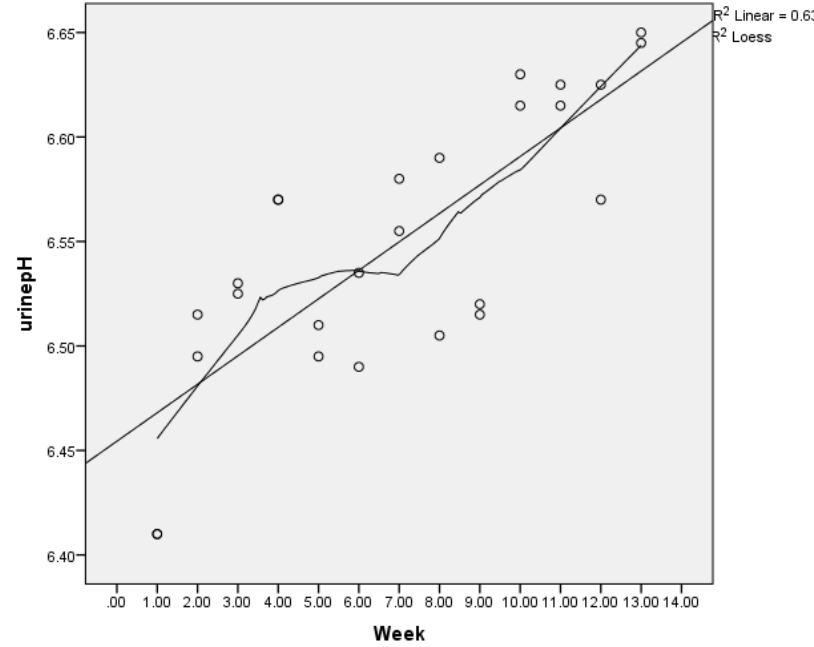
Figure 1. Change in urine pH in intervention Groups A and B. Urine pH was second void, fasted and self-reported by intervention participant’s twice weekly using pH dipsticks. Circles are weekly averages of groups (A and B) together. The graph is fitted with a Lowess smoother line demonstrating increasingly alkaline